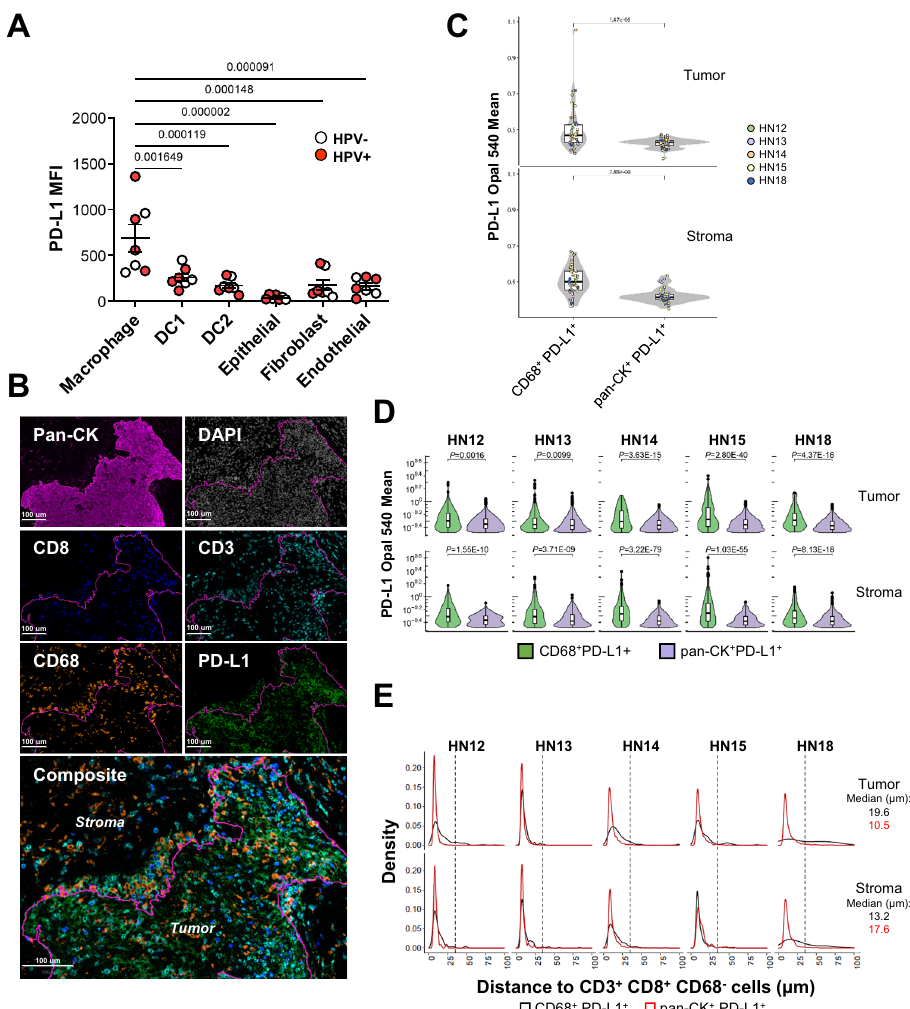
Fig. 8 Macrophages are major contributors of PD-L1 to CD8 + T cells in HNSCC. A Mean fl uorescence intensity (MFI) of PD-L1 on immune (macrophages, DC1, and DC2) and non-immune ( fi broblasts, epithelial, and endothelial) cell types within the HNSCC was evaluated by fl ow cytometry ( n = 7 patients) as depicted in Supplementary Fig. 10. Datapoints represent individual patients. Center lines represent mean values and whiskers depict standard errors of means. p -values were calculated using the one-way ANOVA test. B – E Multispectral immuno fl uorescence (mIF) staining was performed on tumor sections obtained from patients HN12, HN13, HN14, HN15, and HN18 using the conditions described in Supplementary Table 4. Three or more high-resolution images of regions of interest (ROIs) that contained a balance of tumoral (tumor bed) and peritumoral/stromal regions were acquired from each tumor section. ROIs were selected based on H&E staining in addition to mIF whole slide scans. B A representative ROI selected from patient HN12 is shown. Individual channels for pan-CK, DAPI, CD8, CD3, CD68, and PD-L1 are presented, as well as the composite image. Tumor bed is depicted by the cyan-colored border line in the composite image. C Intensity of PD-L1 expression on CD68 + PD-L1 + macrophages and pan-CK + PD-L1 + tumor cells pooled from all patient-associated ROIs is shown ( n = 5 patients). Datapoints represent 41 individual ROIs colored by patient id. D Patient-speci fi c pooled PD-L1 expression levels are shown. 43,517 cells from the 41 ROIs in C were included in the analysis. E Measured distance to CD3 + CD8 + CD68 − T cells from CD68 + PD-L1 + macrophages or pan-CK + PD-L1 + tumor cells pooled from all patient-associated ROIs is shown. Dashed lines represent the 35 μ m distance used as the cutoff to measure cell-to-cell interactions between evaluated cell types. This distance represents 1 – 2 cell diameter distance between macrophages (20 – 30 μ m in diameter) and lymphocytes (5 – 7 μ m in diameter). Calculated median distances across all patients and between evaluated cell types are shown. For boxplots, center lines represent median values, box limits represent upper and lower quartiles and whiskers represent 1.5× interquartile range. One-way ANOVA test was used in A . Linear mixed-effects models were used in C and D , with cell group as a fi xed effect and individual patient as a random effect. BH-FDR method was used for multiple comparison adjustment. All tests are 10.7 μ m, respectively) and stromal (median distance across all patients of 17.6 and 20.0 μ m, respectively) regions of all patients.